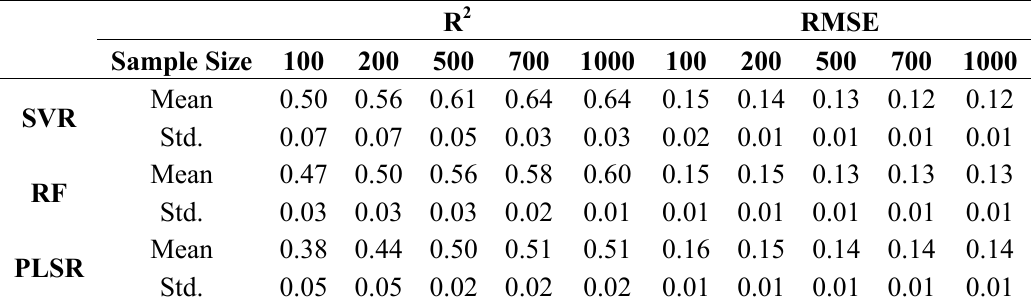
Table 1. Descriptive statistics of the accuracy measures after 30 iterations for all sample